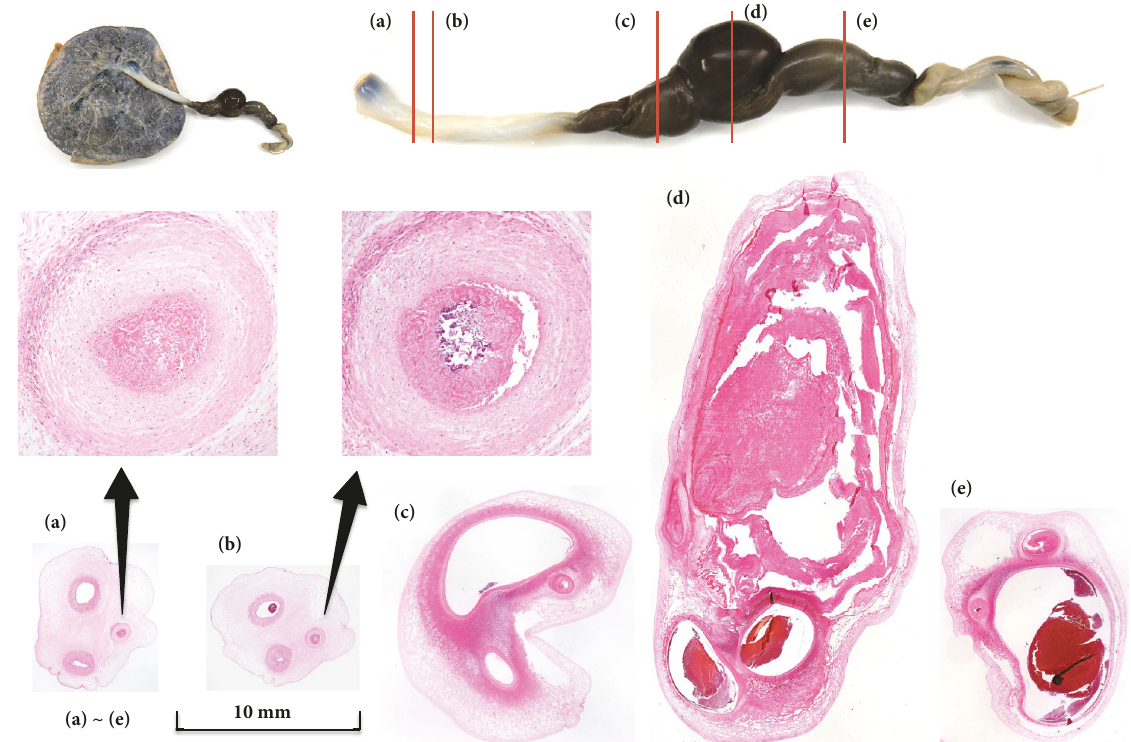
Figure 4: Pathological findings. In the middle of the umbilical cord, there is an area of vascular engorgement (125 mm in length) with central UVV. Cross-section of the cord shows occlusion of one of the umbilical arteries by a fibrin thrombus (a) with central calcification (b). Umbilical vein on both sides of the UVV is markedly dilated (c, e). The UVV, measured 25 x 11 mm, contains a large fresh thrombus